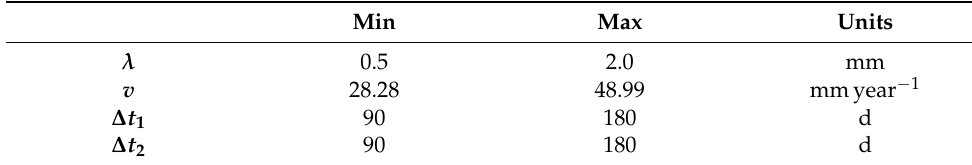
Table 1. Value ranges and units of the uniform distributions used to sample the tumor growth model parameters for the generation of the synthetic tumor dataset.